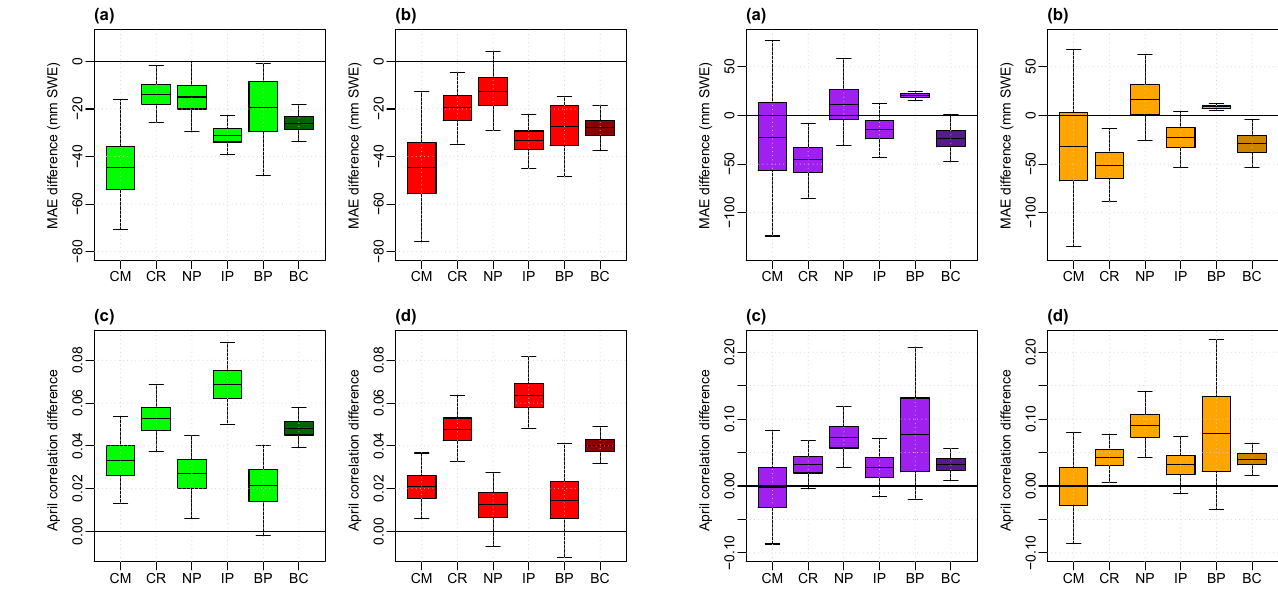
Figure 8. Box plots of bootstrap station differences in MAEs and April correlations showing quartiles and 95% confidence intervals for ANNs of six products, ANN6 (green), and of the best three products, ANN3 (red), relative to MLR6 and MLR3 respectively. Bootstrap difference distributions are shown for (a) ANN6 − MLR6 MAEs, (b) ANN3 − MLR3 MAEs, (c) ANN6 − MLR6 April corre- lations, and (d) ANN3 − MLR3 April correlations. Shown are the differences for each physiographic region: Coast Mountains and Islands (CM), Columbia Mountains and Southern Rockies (CR), Northern and Central Plateaus and Mountains (NP), the Interior Plateau (IP), and the BC Plains (BP), as well as province-wide (BC).